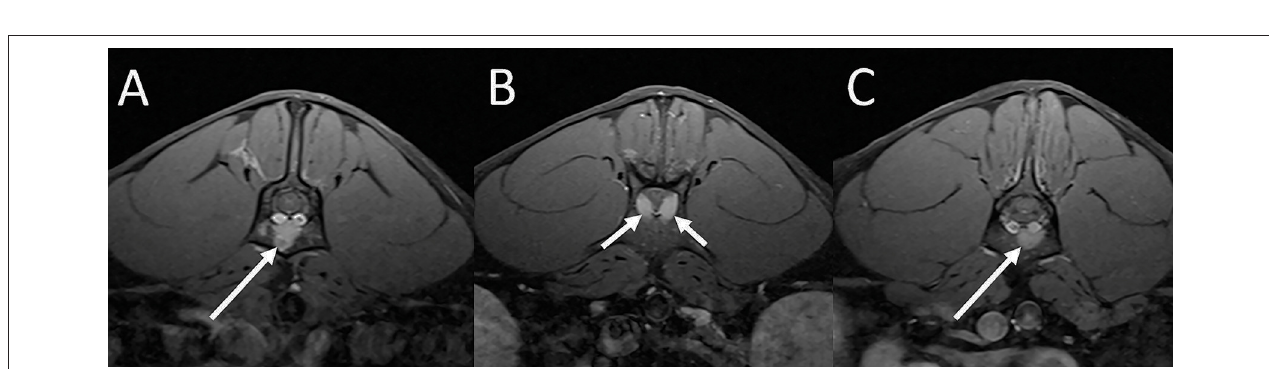
FIGURE 10 | Multiple myeloma in a tiger. Transverse post contrast T1-W FatSat images at the level of L2 (A) , L3 (B) and L4 (C) . There are strongly contrast enhancing polyostotic lesions centered on the medullary cavities of the affected vertebrae, and for the most part exhibit cortical sparing (arrows). The lesion at L3 extends into the vertebral canal, with 2 seemingly separate extradural masses within the left ventral and right ventral aspect of the vertebral canal resulting in marked bilateral ventrolateral spinal cord compression.